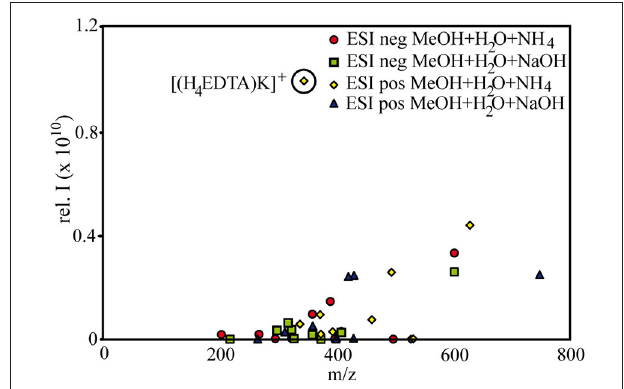
FIGURE 3 | Relationship between molecular weight and signal intensity for samples prepared with a methanol:water matrix. Each point in the correlation plot is the calculated average m/z and average signal intensity of a compound group at a specific setting (e.g., all free citrate ligands in samples with aq. ammonia, detected in negative ionization mode). The outlier is influenced by the denoted